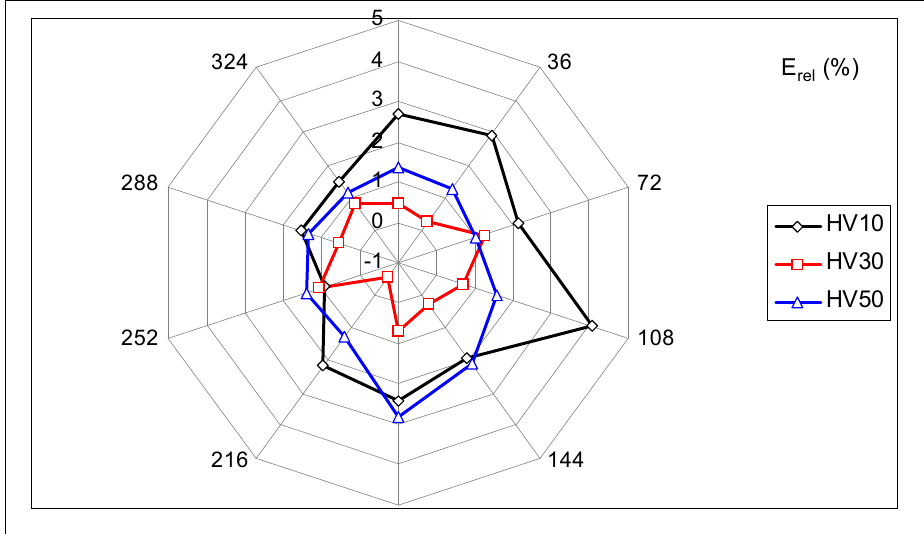
Figure 3 – The influence of the rotation of indenter on the maximal error Erel To determine the influence of the indenter rotation angle on the results of calibration, it was step by step turned by 36° (0°- 324°) after individual calibration. The ambient temperature was 18.8 - 21.2°C. Five indentations were applied along the radius (from centre to rim) of CRM in equidistant